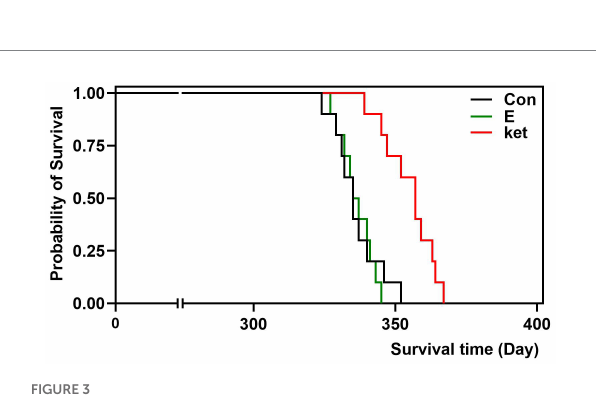
FIGURE 3 Treatment with estrogen did not delay the onset of stroke in aged rats. Lifelong treatment of Ket (0.3 mg/kg/d) postponed the stroke death of SHRSP (log-rank testing χ 2 = 13.49, p = 0.002), whereas estrogen treatment did not postpone the stroke development of old SHRSP. N = 10 per group. The Kaplan–Meier analysis was used to estimate survival probabilities in the